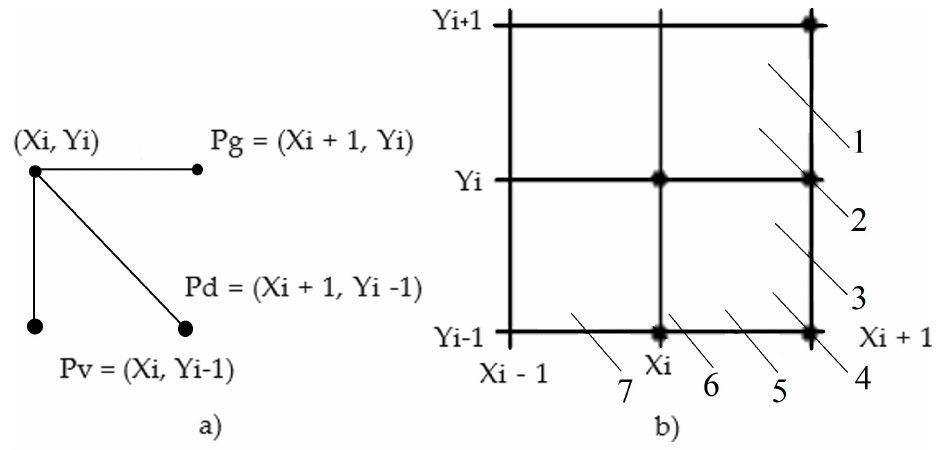
Figure 7. Options for the location of the next pixel of the circle: ( a ) Choosing a possible way to calculate the next step; ( b ) Selection of possible point